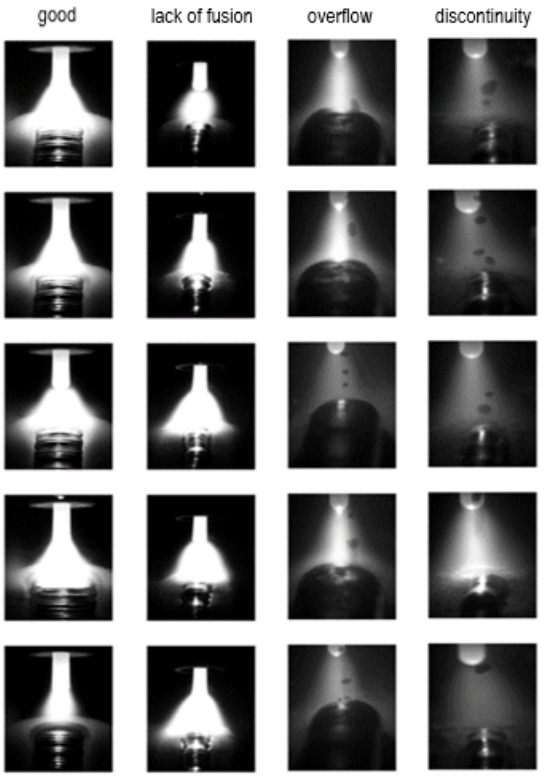
Figure 5. Four types of data after region of interest (ROI) segmentation. “good” (582) vs. “lack of fusion” (641) vs. “overflow” (589) vs. “discontinuity” (588).